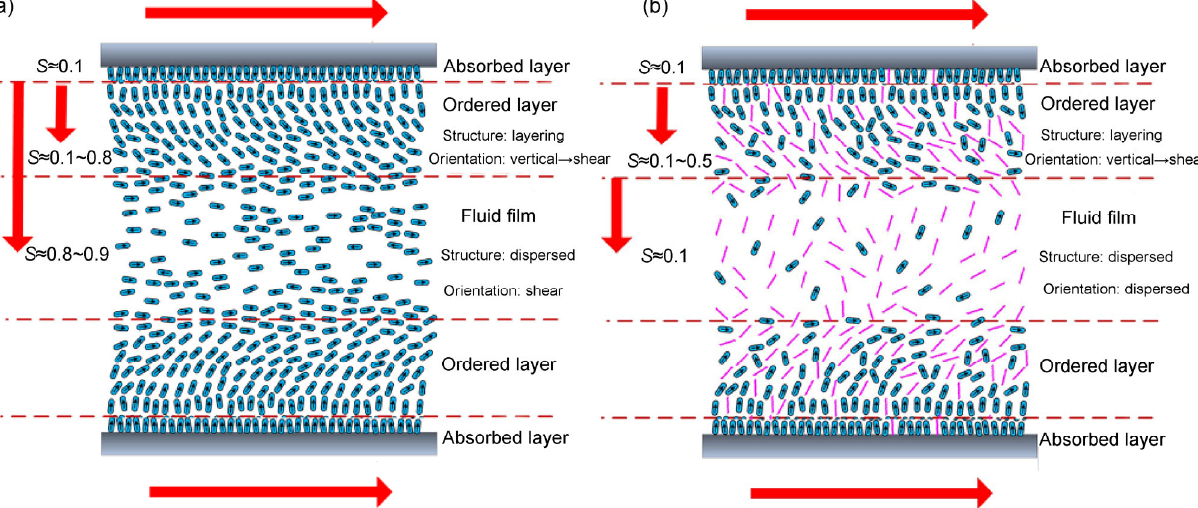
Fig. 15 Molecular structures of 5CB in (a) nonpolar solvent (hexadecane) and (b) polar solvent (decanol), proposed by Zhang and Luo